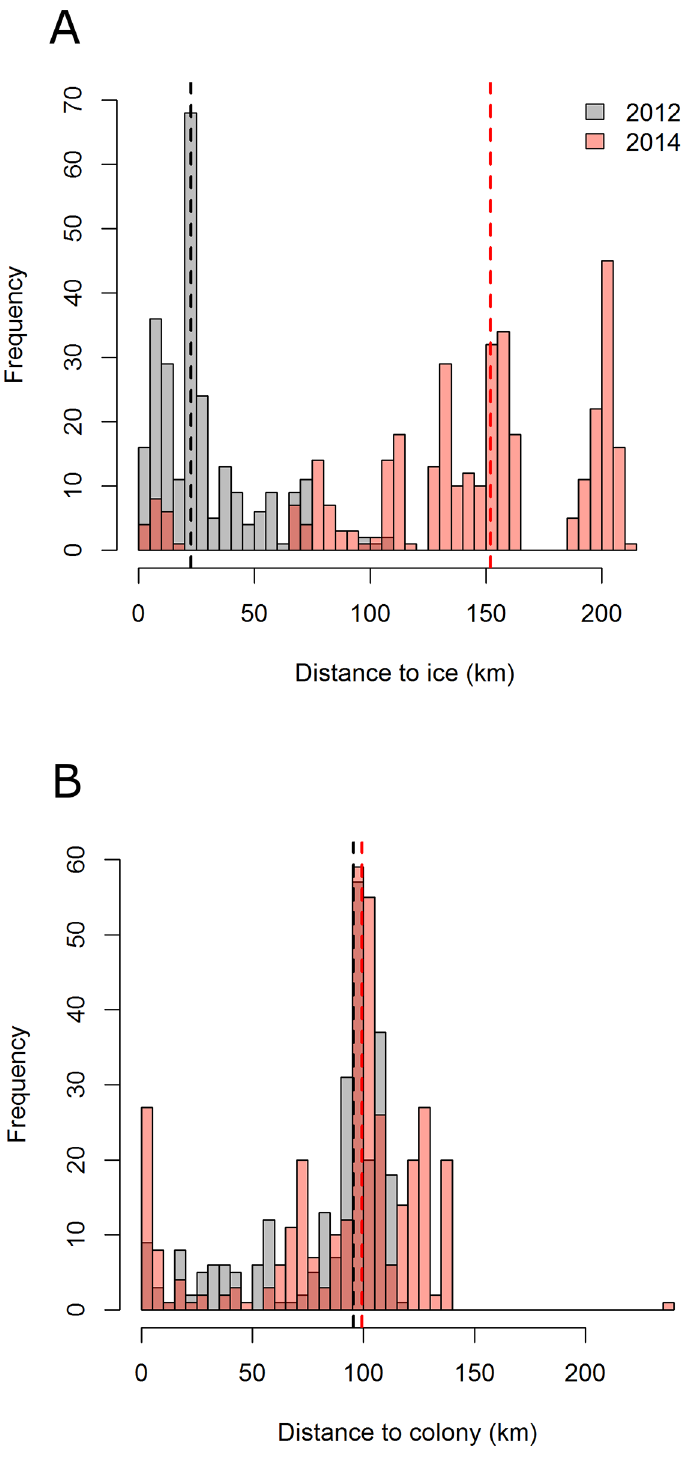
Fig 3. Histograms of the distance to (A) the ice (80% sea ice concentration) and (B) to the colony for foraging and resting positions in 2012 (grey) and 2014 (red). Vertical bars correspond to median values for each